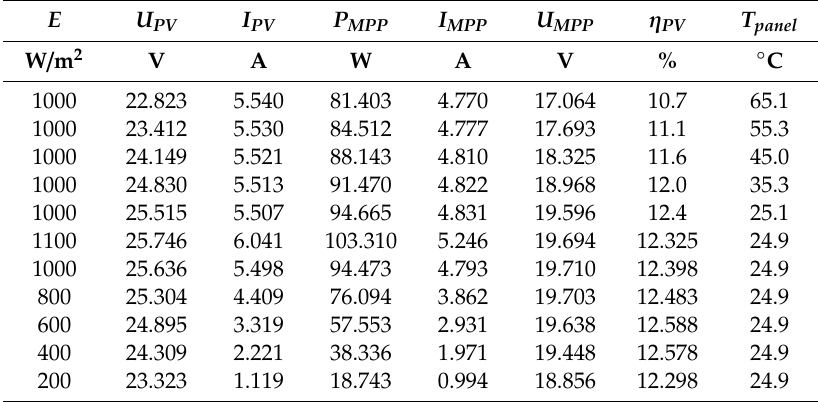
Table 2. Results from the measurements in the sun